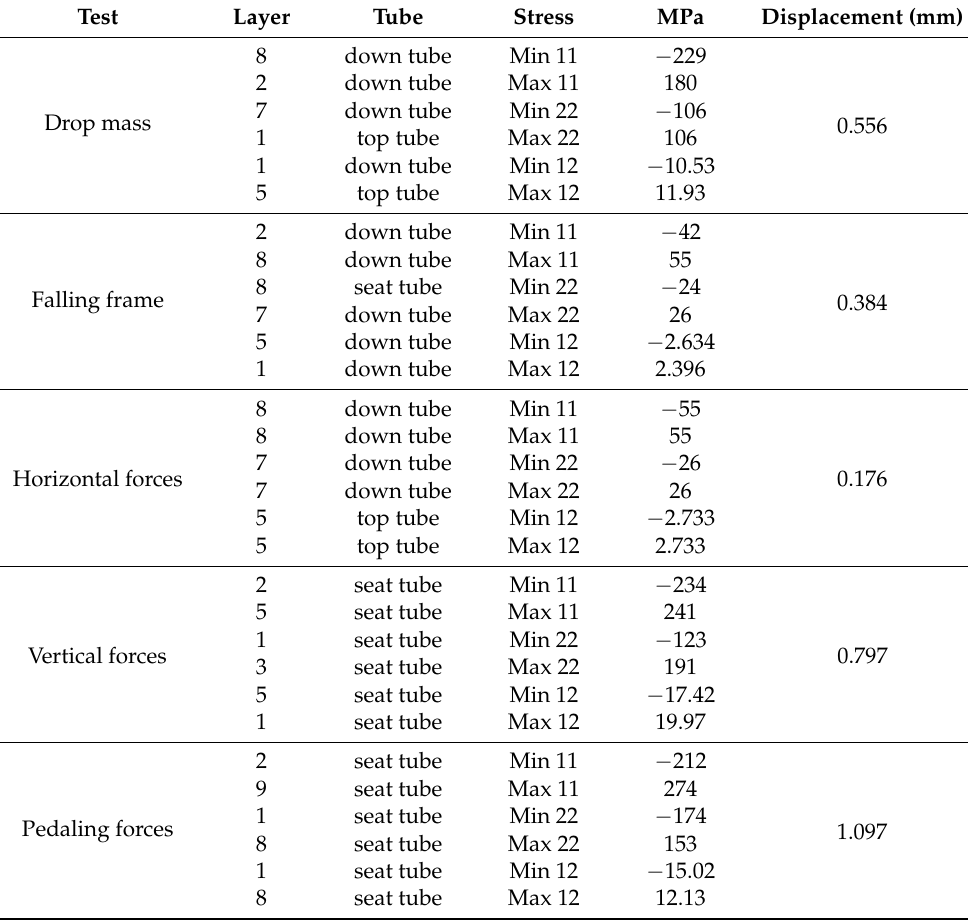
Table 27. Stress and displacement results of stacking scenario